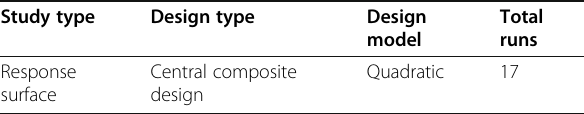
Table 5 Design summary for optimization Study type